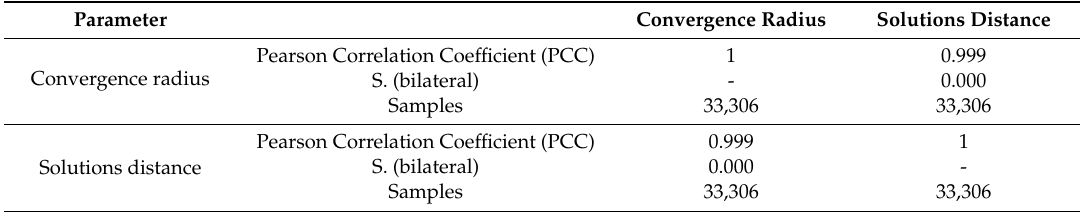
Table 1. Correlation between radius of convergence and distance between solutions.